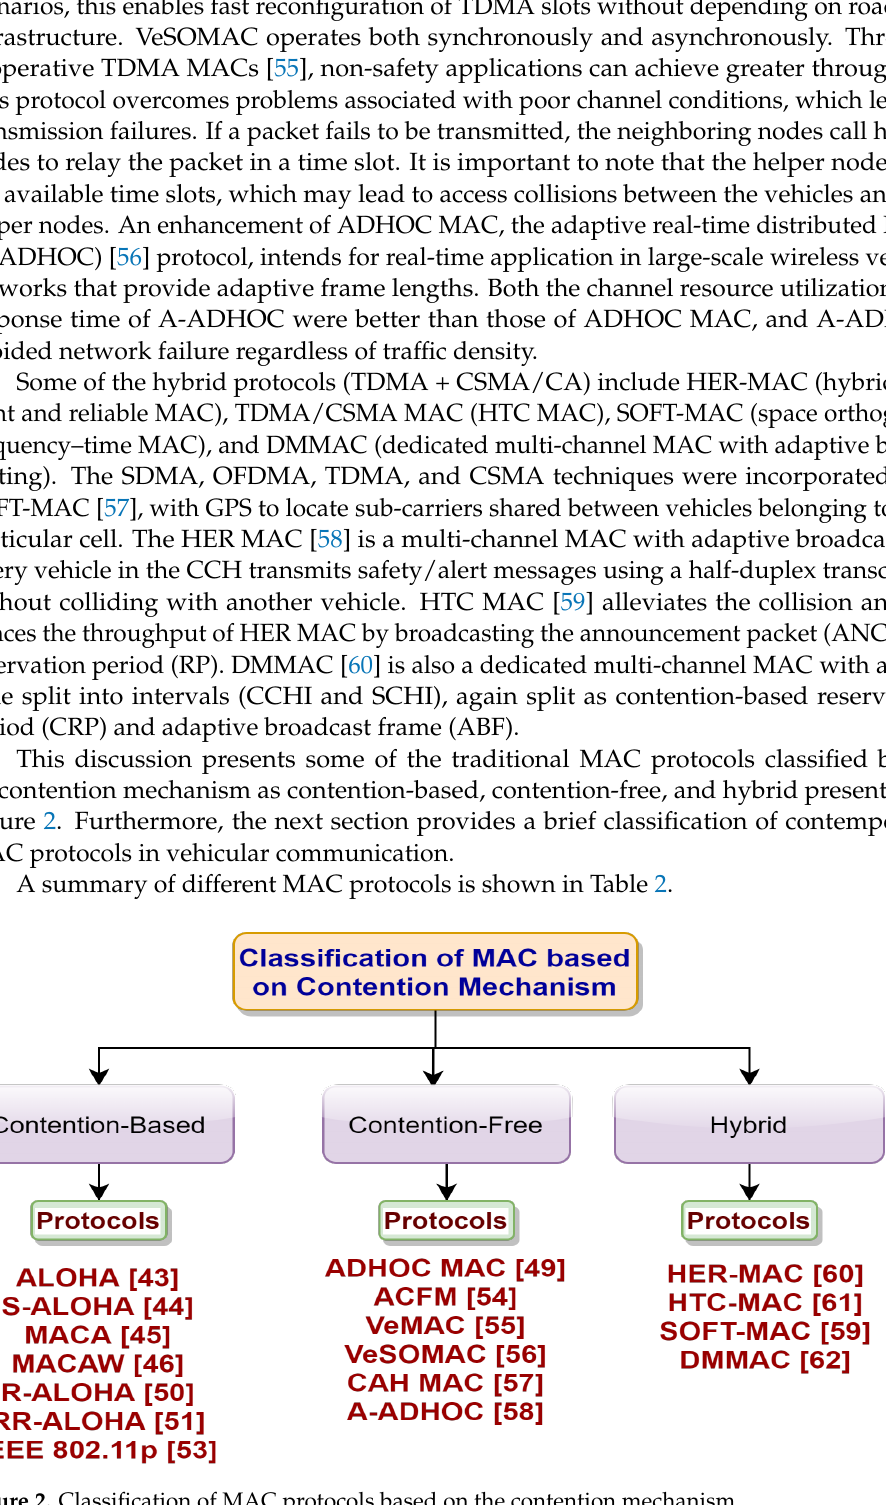
Figure 2. Classification of MAC protocols based on the contention